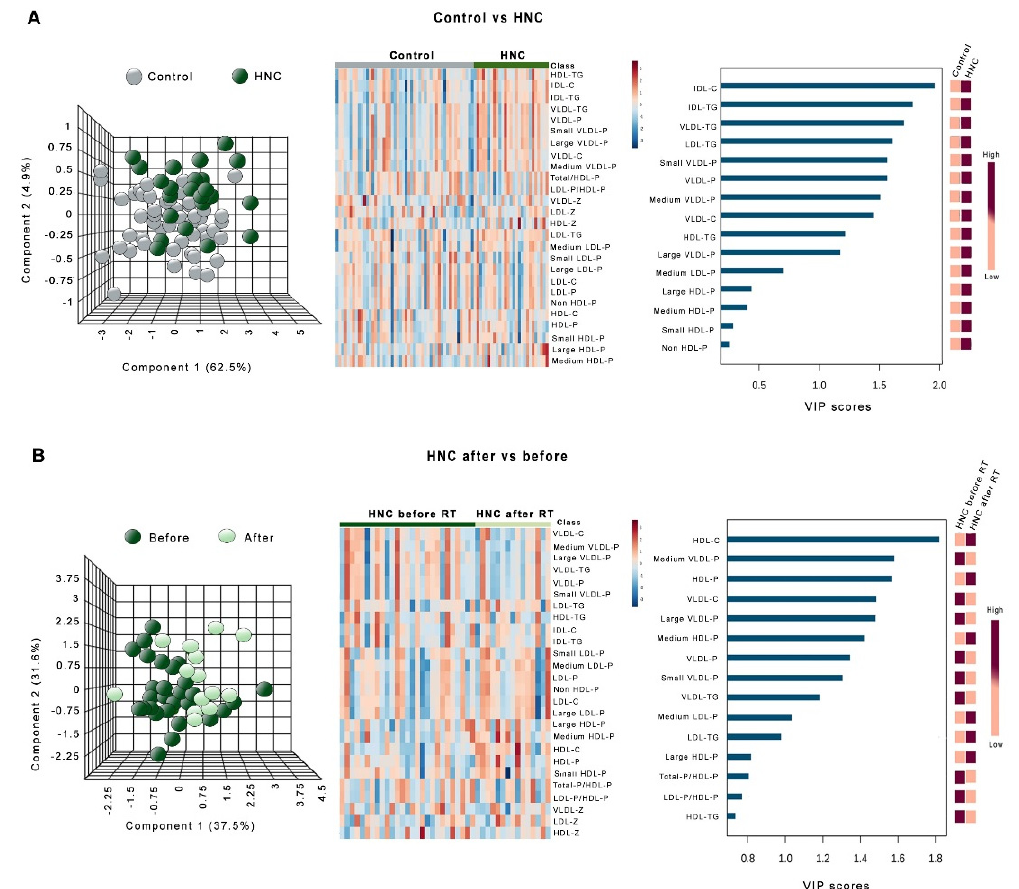
Figure 4. Principal component analysis (PCA) scores, heatmaps, and variable importance in projection (VIP) scores of the partial least squares discriminant analysis (PLSDA) in head and neck cancer (HNC) patients vs. the control group ( A ) and in HNC patients before and after radiotherapy ( B ). HDL: High-density lipoproteins; IDL: Intermediate-density lipoproteins; LDL: Low-density lipoproteins; VLDL: Very-low-density lipoproteins. The suffix –P indicates number of particles, and the suffix –Z indicates the particle diameter.